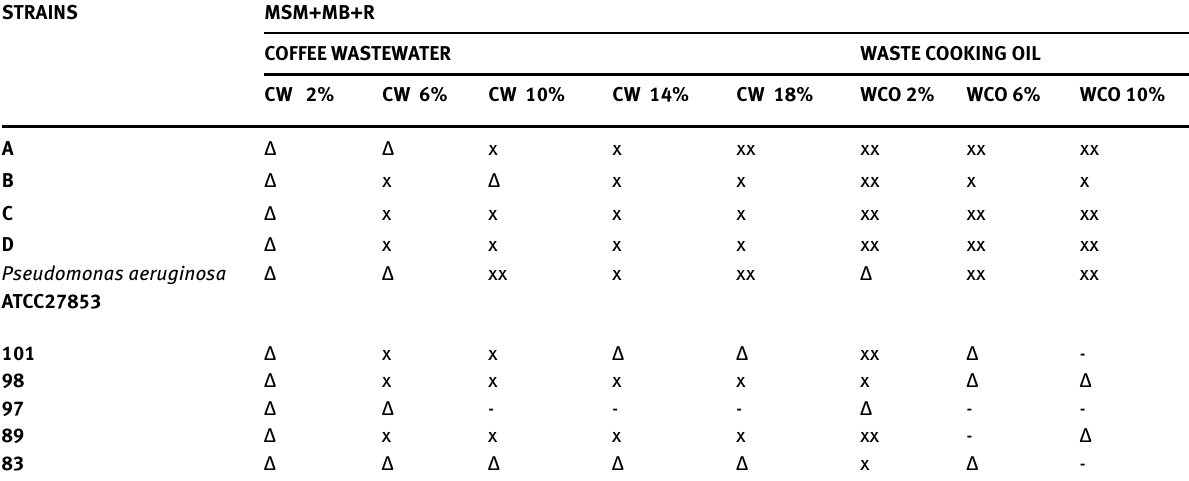
Table 1: Solid selective medium assay with bacterial strains, forming of halo as indirect evidence of biosurfactant production